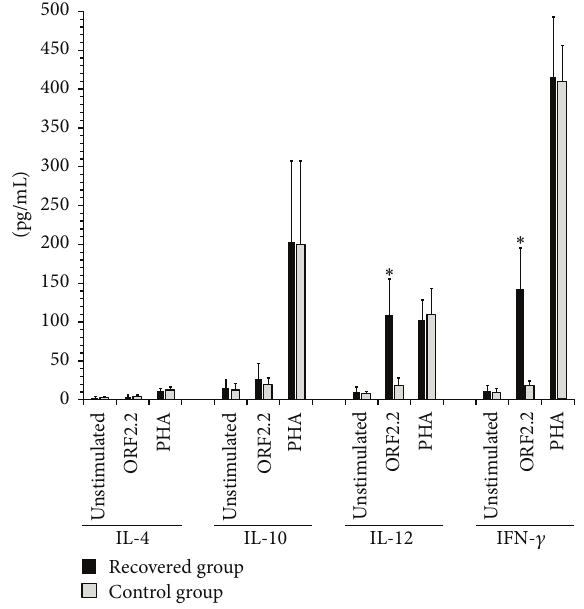
Figure 3: The levels of IL-4, IL-10, IL-12 p70, and IFN- 𝛾 cytokines in HEV-recovered and control groups following stimulation with the truncated ORF2 protein. Significant amounts of IFN- 𝛾 and IL- 12 cytokines but low amounts of IL-10 and IL-4 cytokines were produced. IL-12 p70 and IFN- 𝛾 cytokines production following stimulation with the truncated ORF2 protein was significantly higher in the recovered group compared to the control group, while there were no significant differences in the levels of IL-10 and IL- 4 between the two groups. Both groups showed almost similar expression of all cytokines following stimulation with PHA. Results are shown as mean ± SD